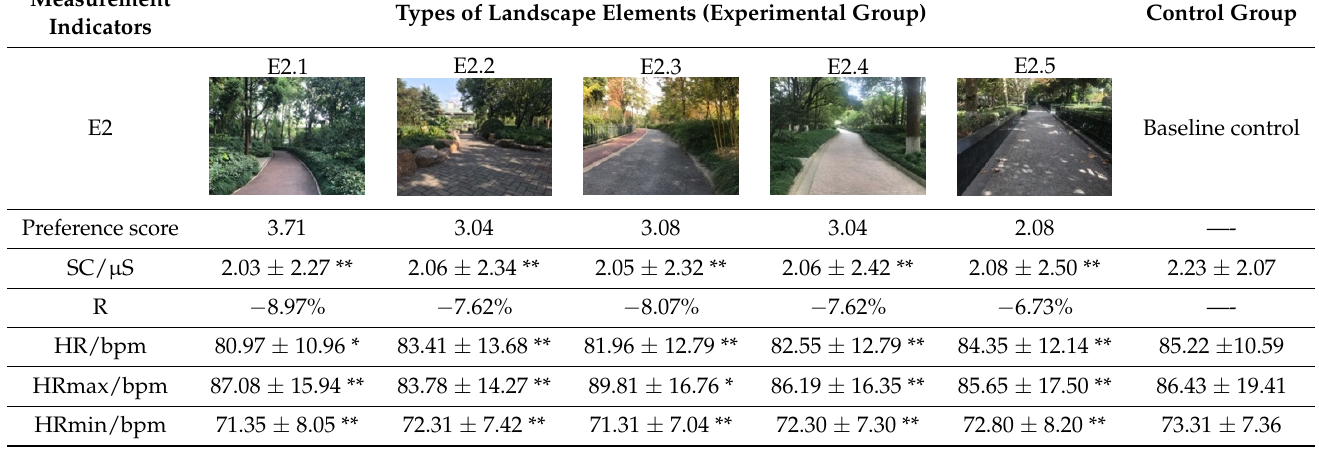
The data in the table are shown as the mean ± standard deviation. * Indicates significance at a level of p < 0.05. ** Indicates significance at a level of p < 0.01.